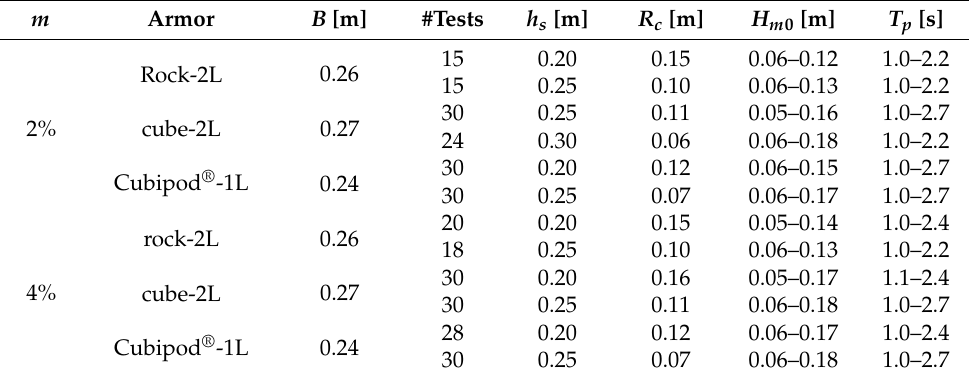
Table 3. Structure and wave characteristics of the physical